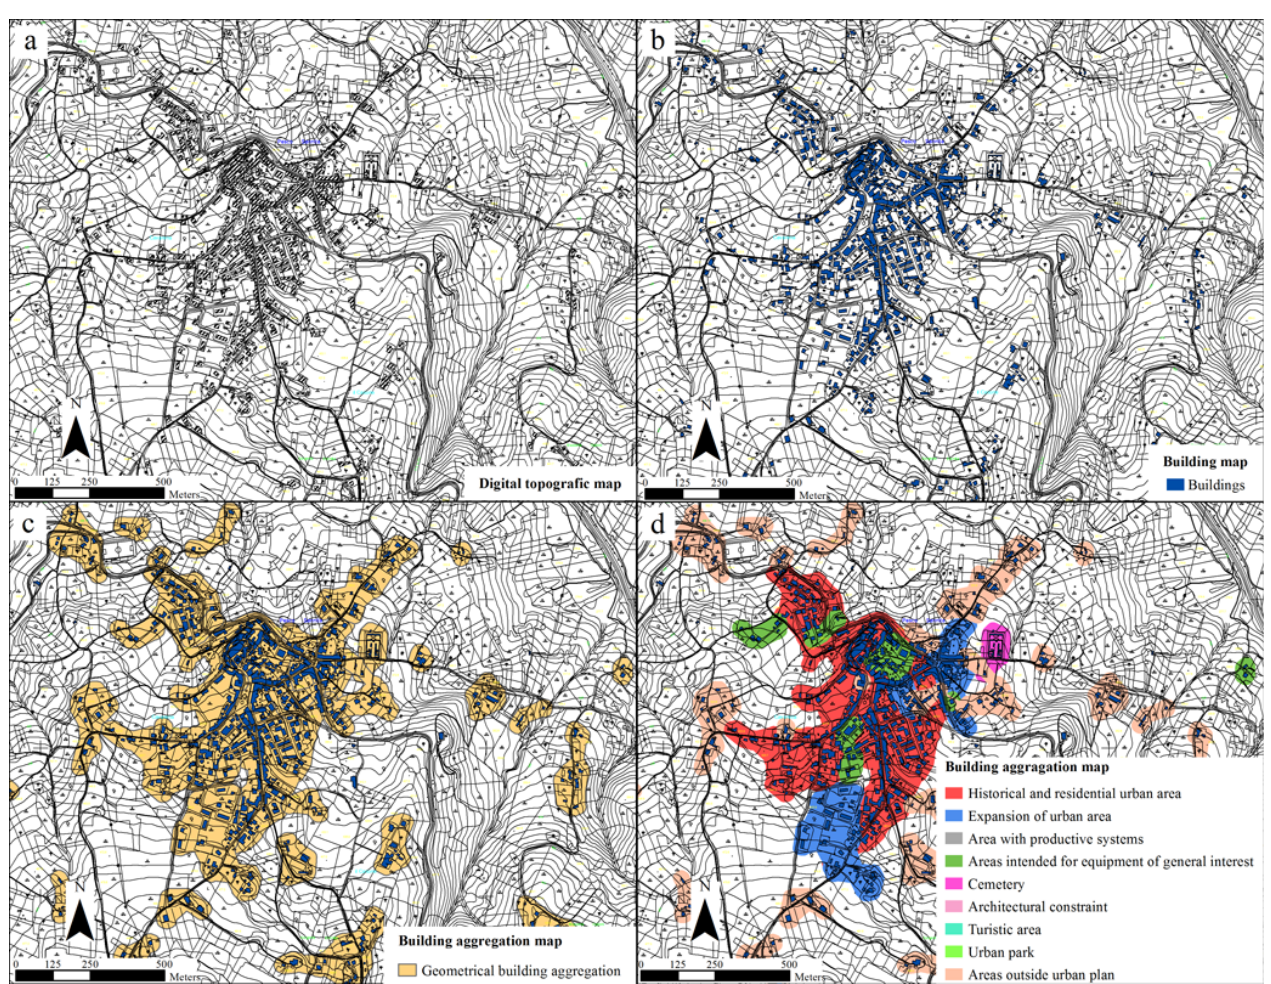
Fig. 10. (a) The urban centre of Pesco Sannita municipality; (b) identification of buildings; (c) definition of building aggregations only on geometrical bases; (d) building aggregations distinguished according to the occupancy